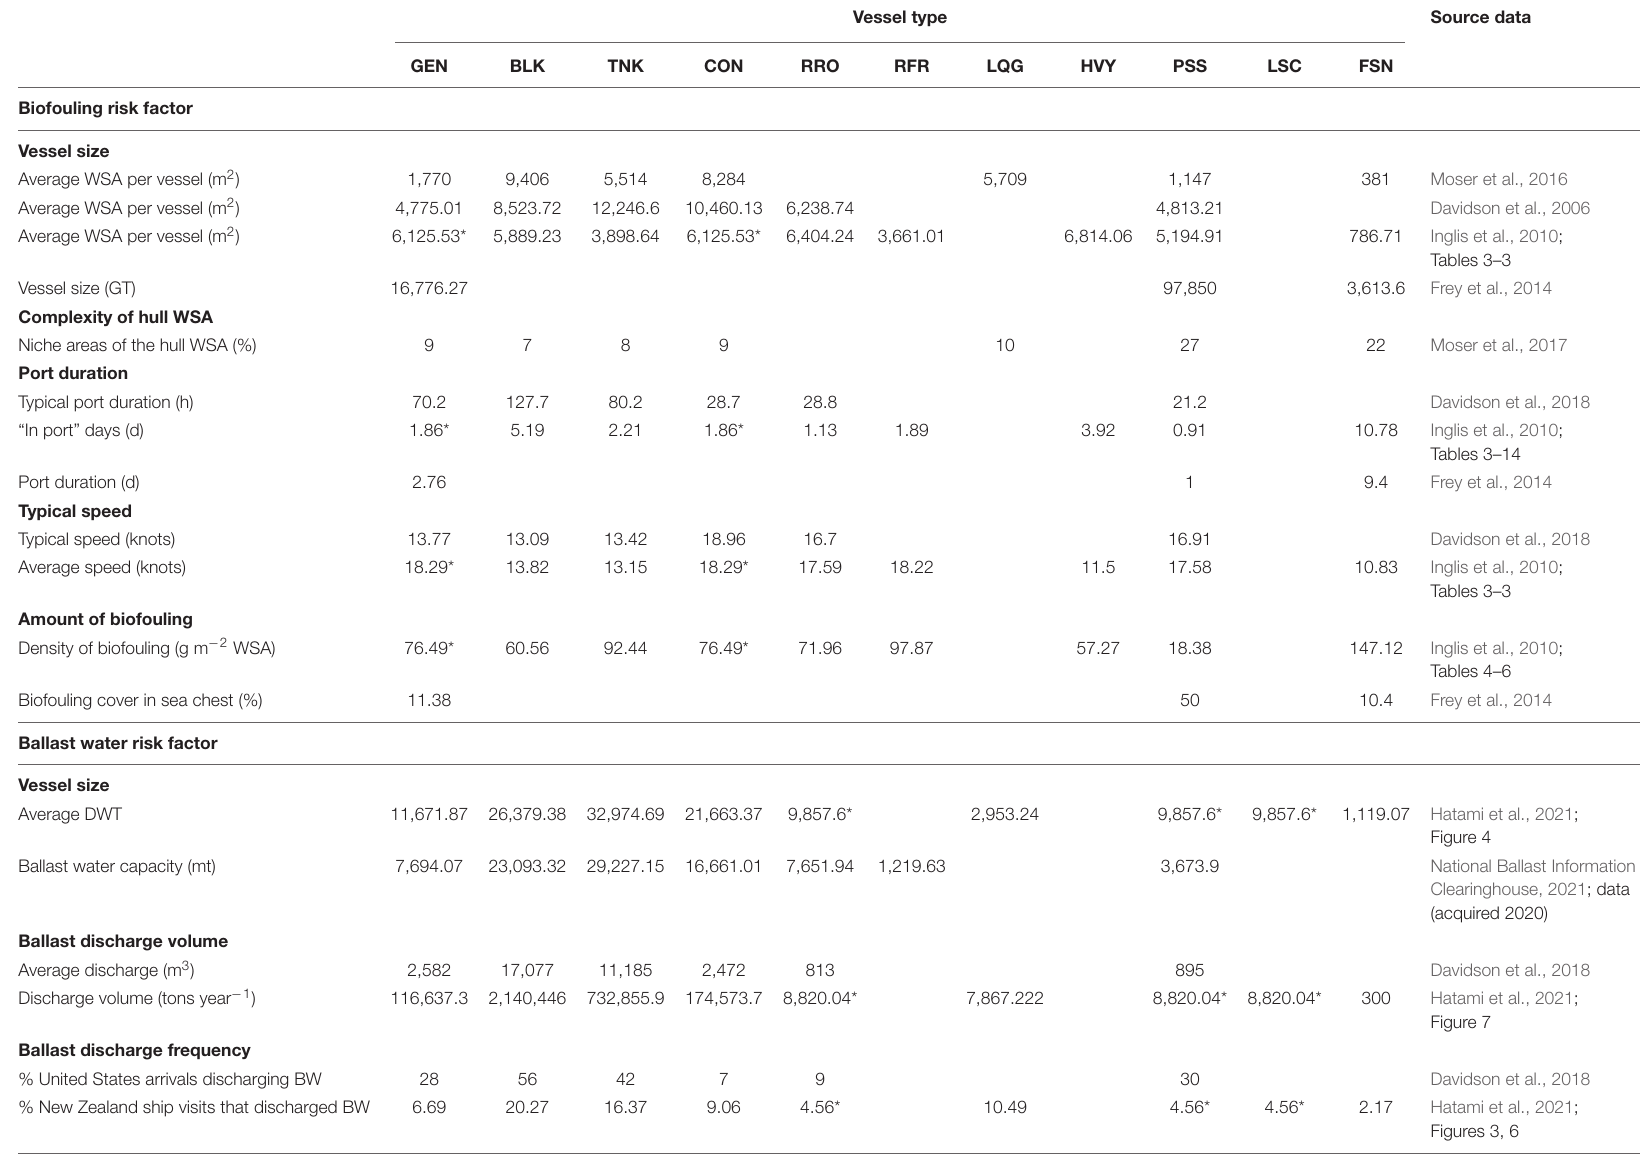
TABLE 3 | Data from each data source for each combination of risk factor and vessel